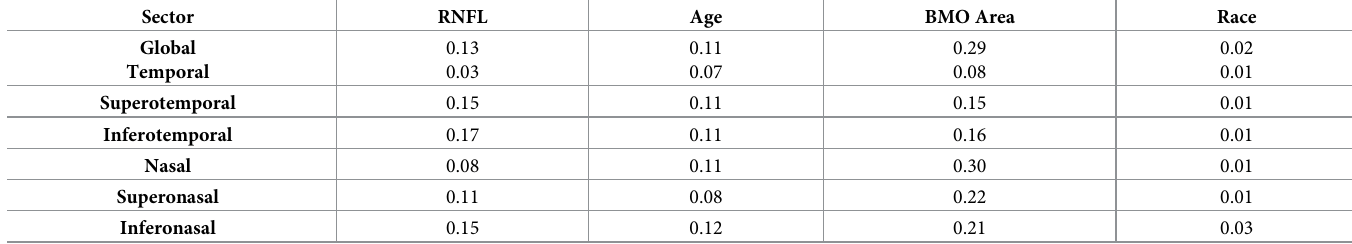
Table 5. Multivariable regression model evaluating the relationship between sectorial Minimum Rim Width (MRW) and peripapillary retinal nerve fiber layer thickness (RNFLT), adjusted for Bruch’s membrane opening (BMO) area, age and race. Partial R squared estimating the relative importance of each predictor are